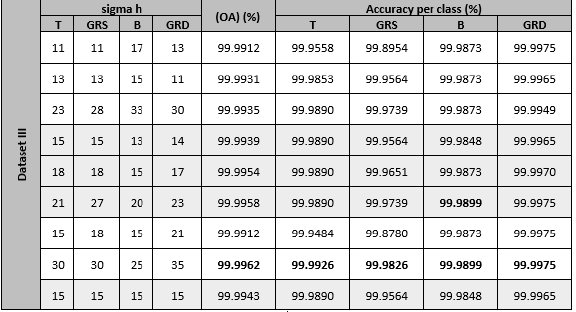
Table 3. Accuracy assessment of dataset II. Accuracy assessment of dataset I. Note: T=Tree, GRS=Grass, B=Building, GRD= Ground/Road, and OA = Overall Accuracy.